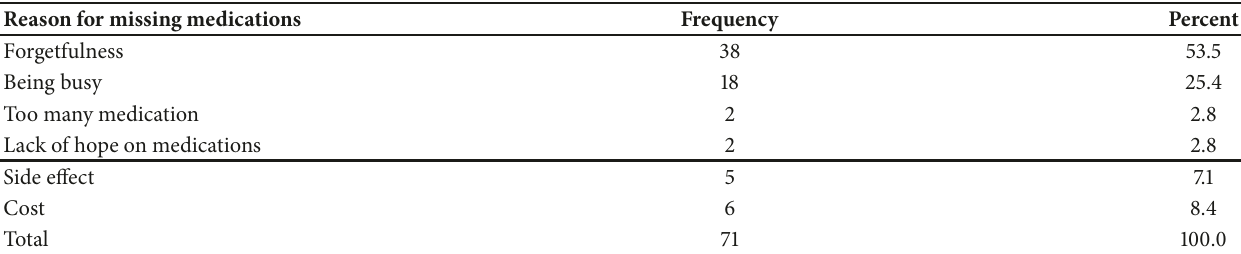
Table 2: Patient’s reason for missing their antiepileptic medication at DRH, Dessie, Ethiopia, from April to June 2017. Reason for missing medications